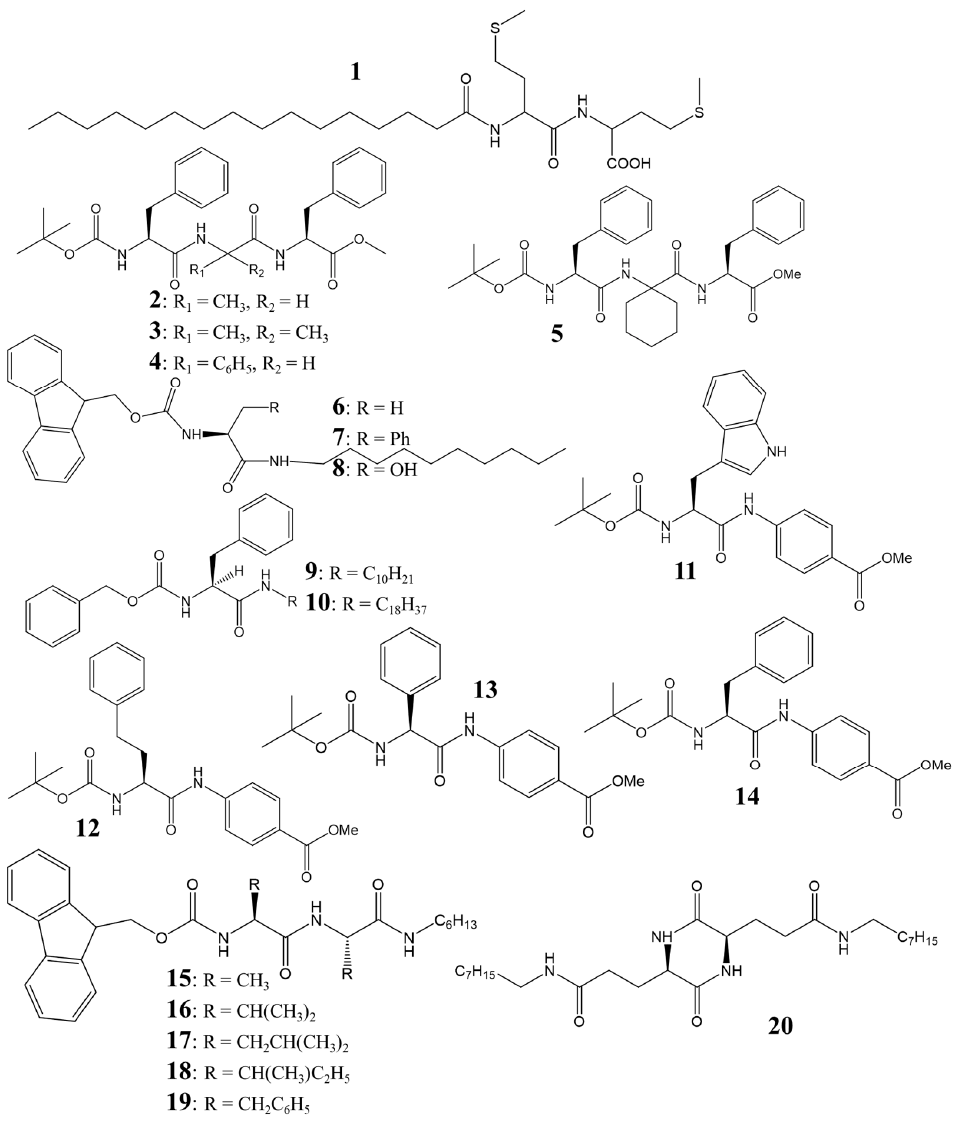
Figure 2. Chemical structures of PSOGs 1 – 20 .